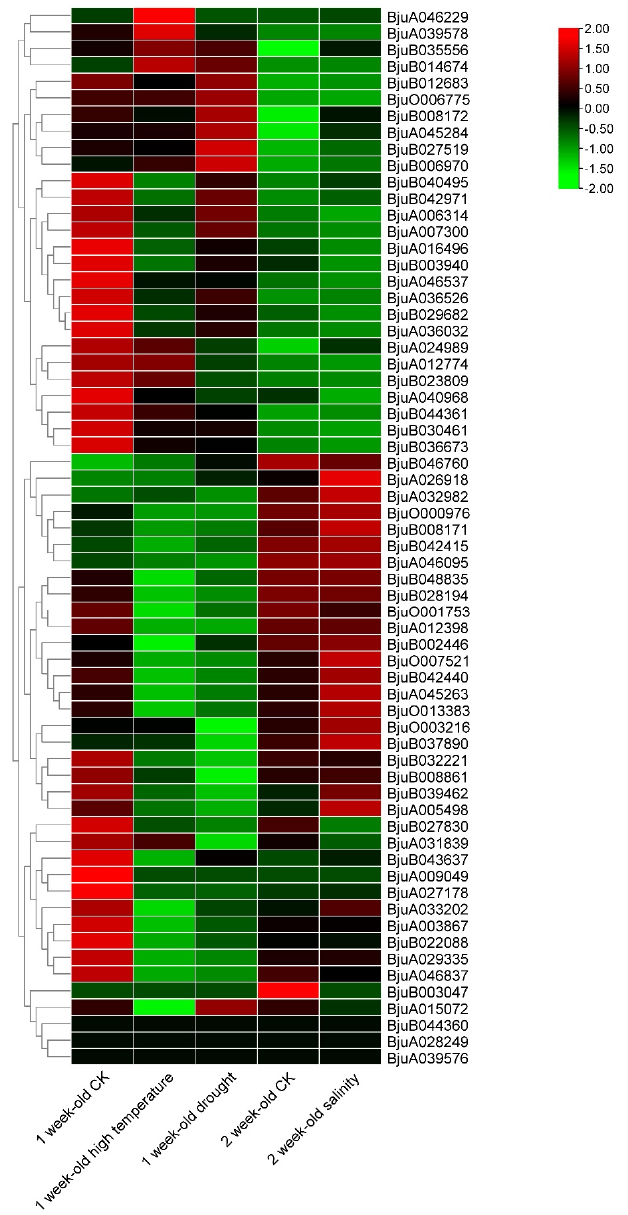
Figure 5. Expression profiles of BjMYB-CC genes under different stress conditions. Transcript abundance was normalized according to TPM (transcripts per million mapped reads) values, wherein the TPM values were log2 transformed. The color scale represents relative expression levels from low (green-colored) to high